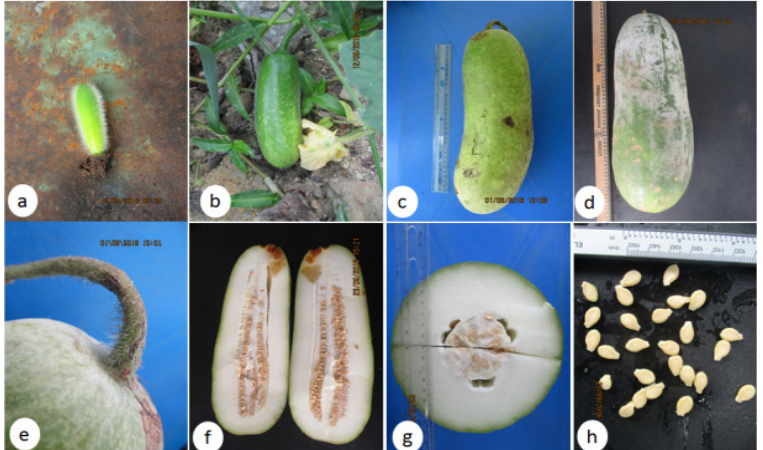
Fig. 2. Fruits and seeds of B. hispida : a – c. young/immature fruits, d. mature fruit, e. hairy fruit-stalk, f. longitudinal view of the fruit, g. transvers view of the fruit, and h. Table 1. Epidermal characteristics of leaf, male and female flowers of B. hispida Epidermal